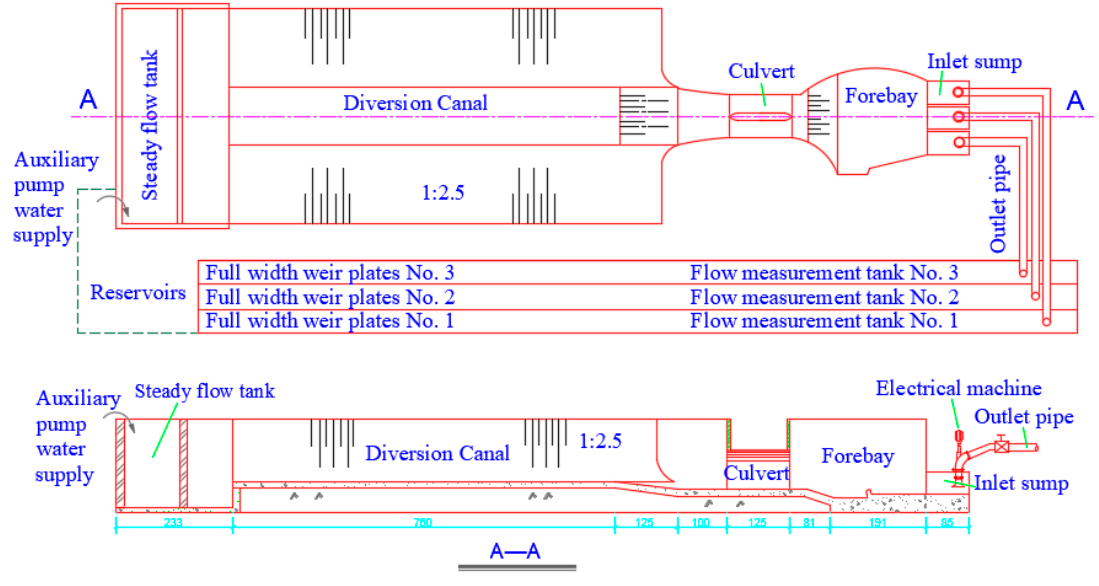
Figure 5. The layout of the model test.